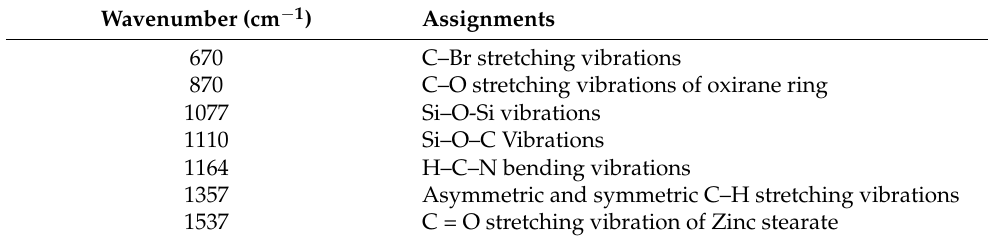
Table 4. Assignments of the peak of infrared spectra in Figure